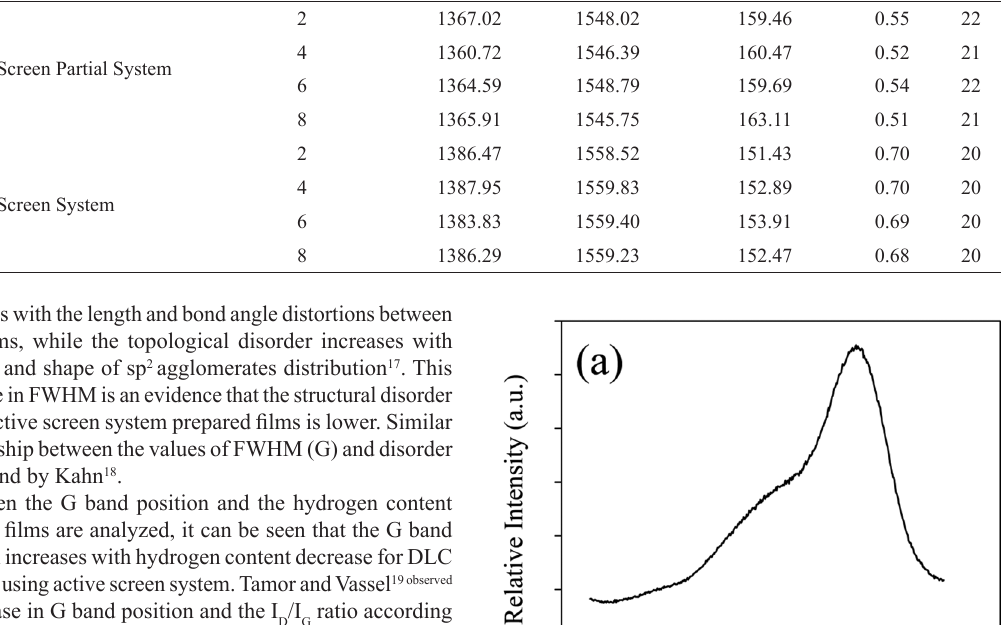
Table 1: Summarized Raman spectra results of DLC films according to system and bias voltage. System